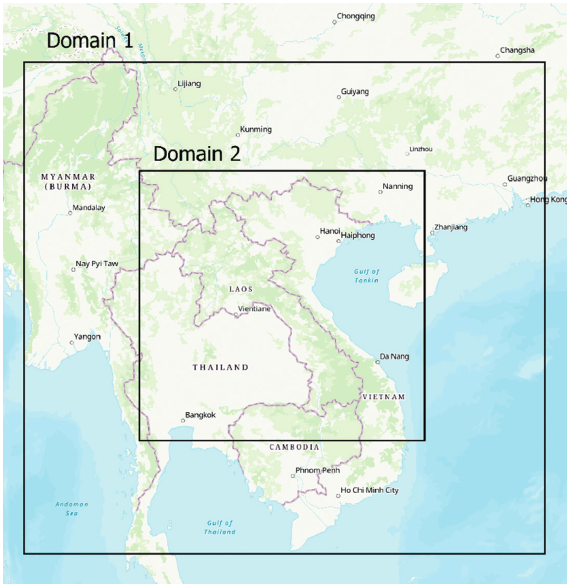
Figure 1: Domain configuration of the WRF